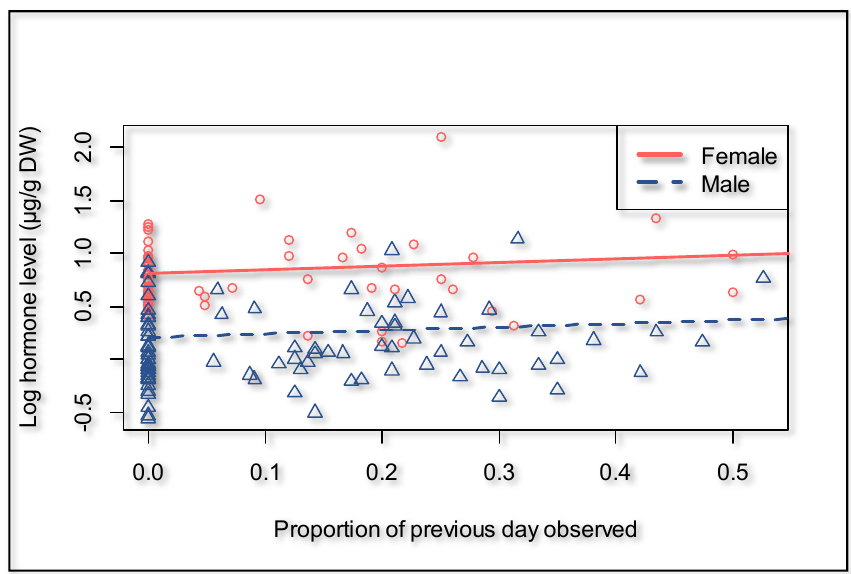
Figure 7. Effect of the presence of human observers on fGCM concentration, showing the proportion with respect to the previous day observed, to account for the time lag in hormone metabolite expression (0.0 = observer absent).